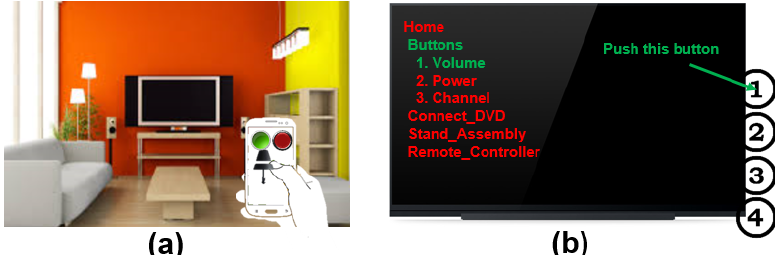
Figure 2. Augmented reality (AR) control for electronic systems: ( a ) physical light control through remote touch based on the AR platform [24]; ( b ) control status for the operating manual using AR visual information [1].